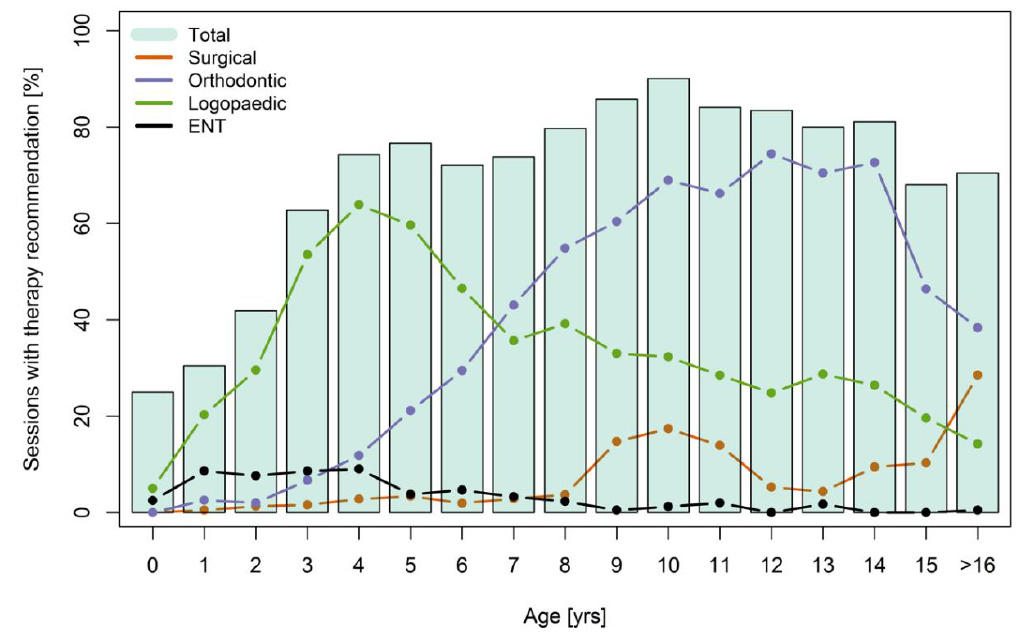
Figure 3. Proportion of consultations in which specific therapy recommendations were given by the participating specialists. ENT: Ear Nose Throat Physician.